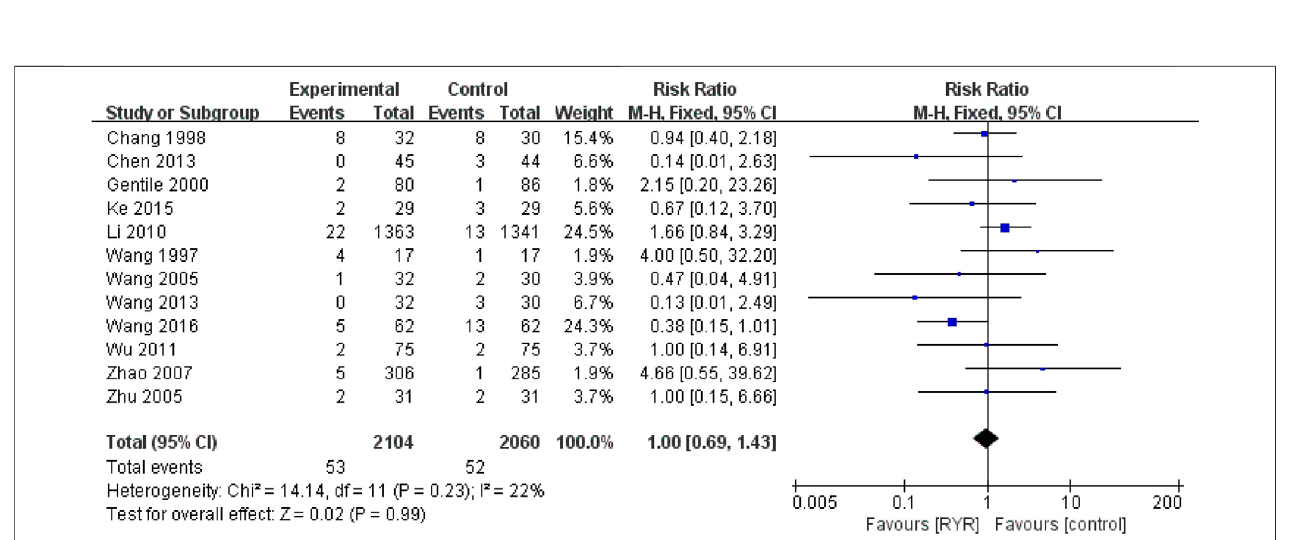
FIGURE 6 | Forest plot of the adverse